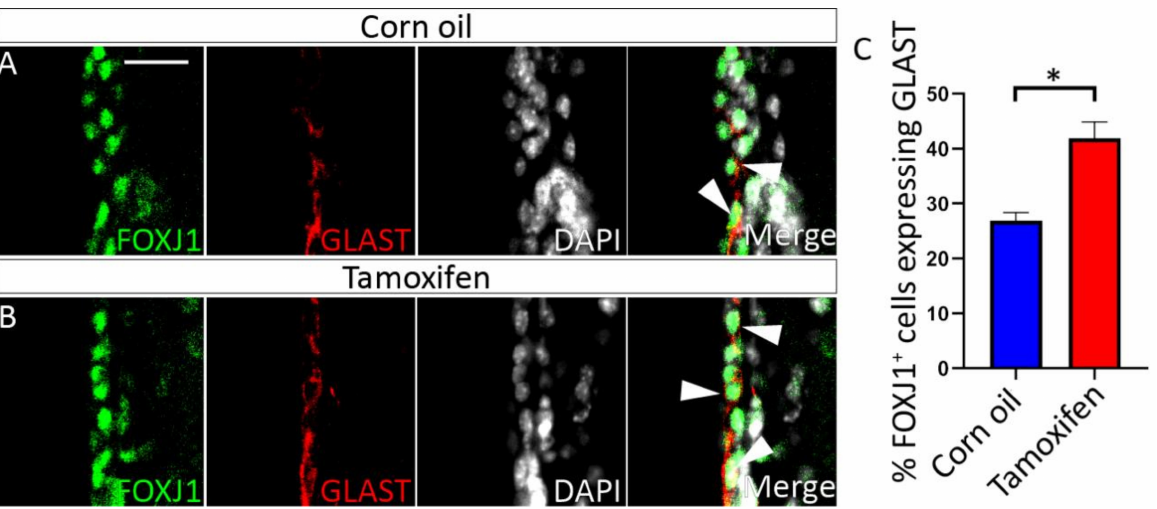
Figure 8. Some tamoxifen treated Nfix iFOXJ1 − GFP FOXJ1 + ependymal cells express GLAST. ( A , B ) Lat- eral ventricle sections of corn oil ( A ) and tamoxifen ( B ) treated adult Nfix iFOXJ1 − GFP ependyma marked with antibodies against ependymal marker FOXJ1 (green), radial glia marker GLAST (red) and nuclear marker DAPI (grey), displayed as separate images or merged. White arrowheads are used to mark FOXJ1 + , GLAST + cells. ( C ) The percentage of FOXJ1 + cells that also expressed GLAST is displayed for tamoxifen treated Nfix iFOXJ1 − GFP ependymal cells and controls. The percentage of FOXJ1 + cells expressing GLAST is higher in tamoxifen treated Nfix iFOXJ1 − GFP mice compared to controls. * p < 0.05 two − tailed t -test. Graphs depict mean ± s.e.m. from three samples per genotype. Scale bar ( A ) represents 25 µ